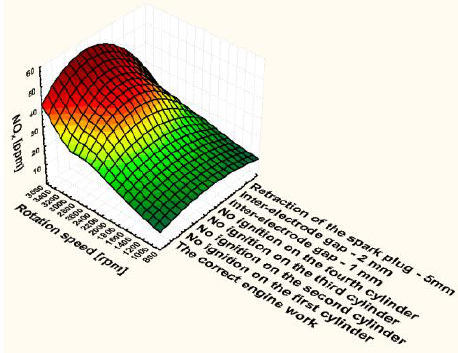
Fig. 22. The content of nitrogen oxides emitted by the BMW M10B18 petrol-powered engine